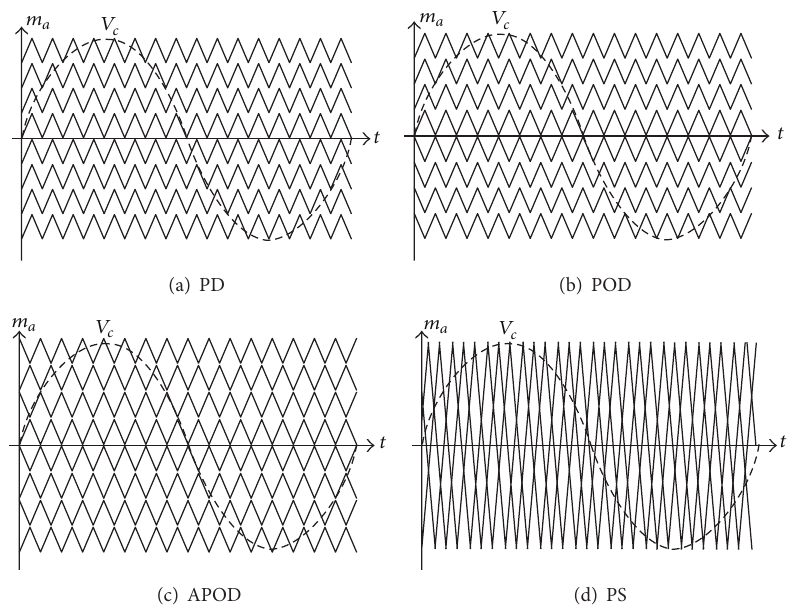
Figure 6: Multicarrier SPWM control strategies. The sinusoidal control reference 𝑉 𝑐 is compared with different types of carrier waveforms to generate the switching logic for the H-bridges.